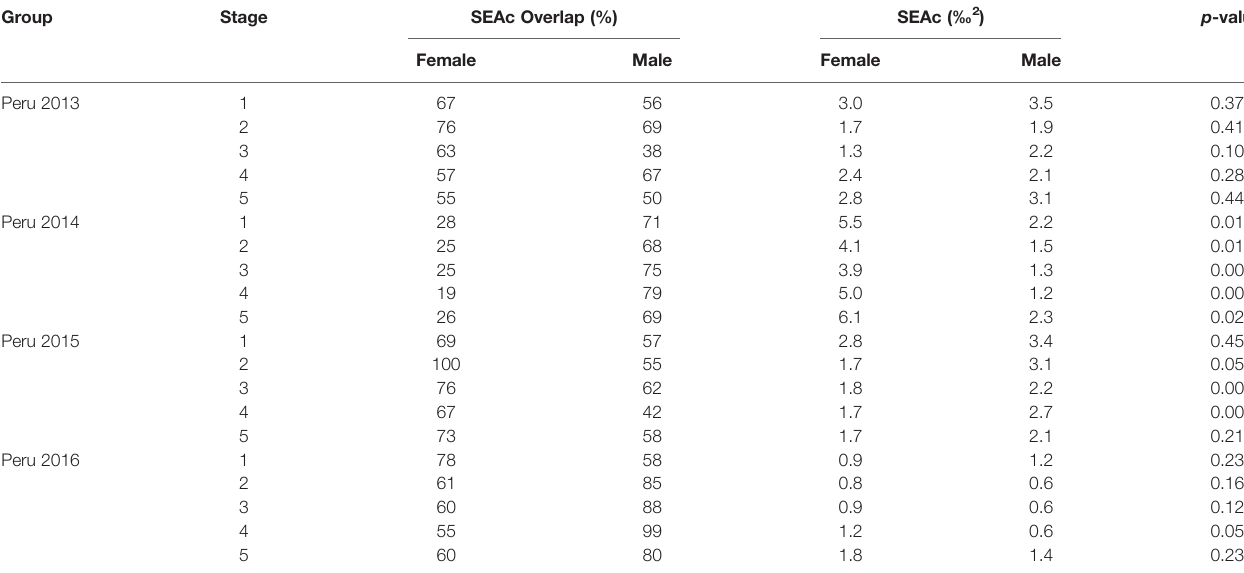
TABLE 8 | Sexual variation in isotopic niche off Peru in different years ( “ Peru 2013 ” represents the samples collected off Peru during 2013, and so on). Group Stage